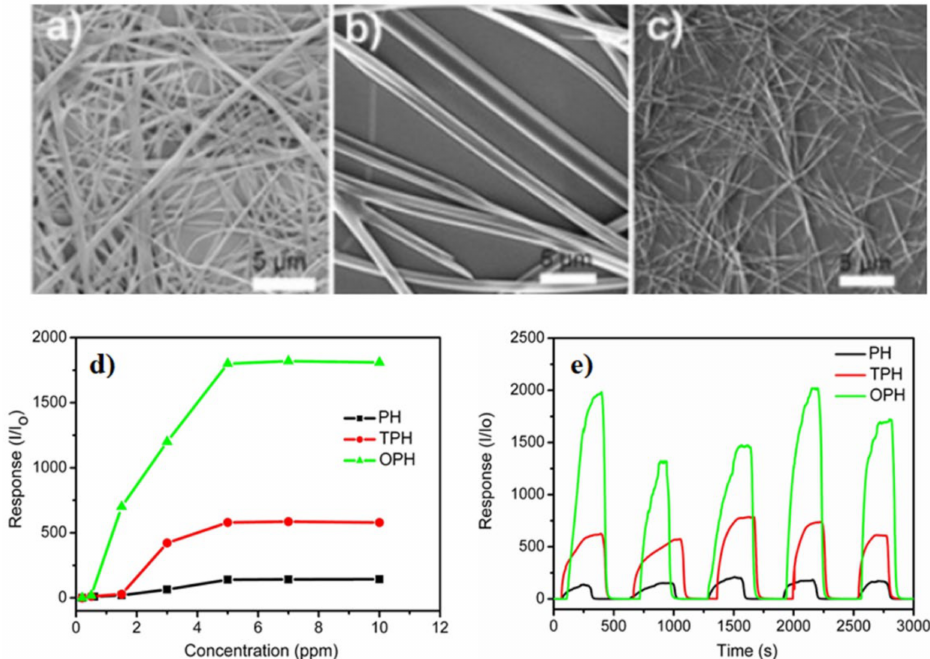
Figure 8. SEM images of microstructures of the ( a ) PH, ( b ) TPH, and ( c ) OPH PDIs. ( d ) The response modulation–concentration curves show an enhancement in OPH and ( e ) the dynamic responses of the PH, TPH, and OPH devices in hydrazine vapor (5 ppm). Adapted with permission [83].